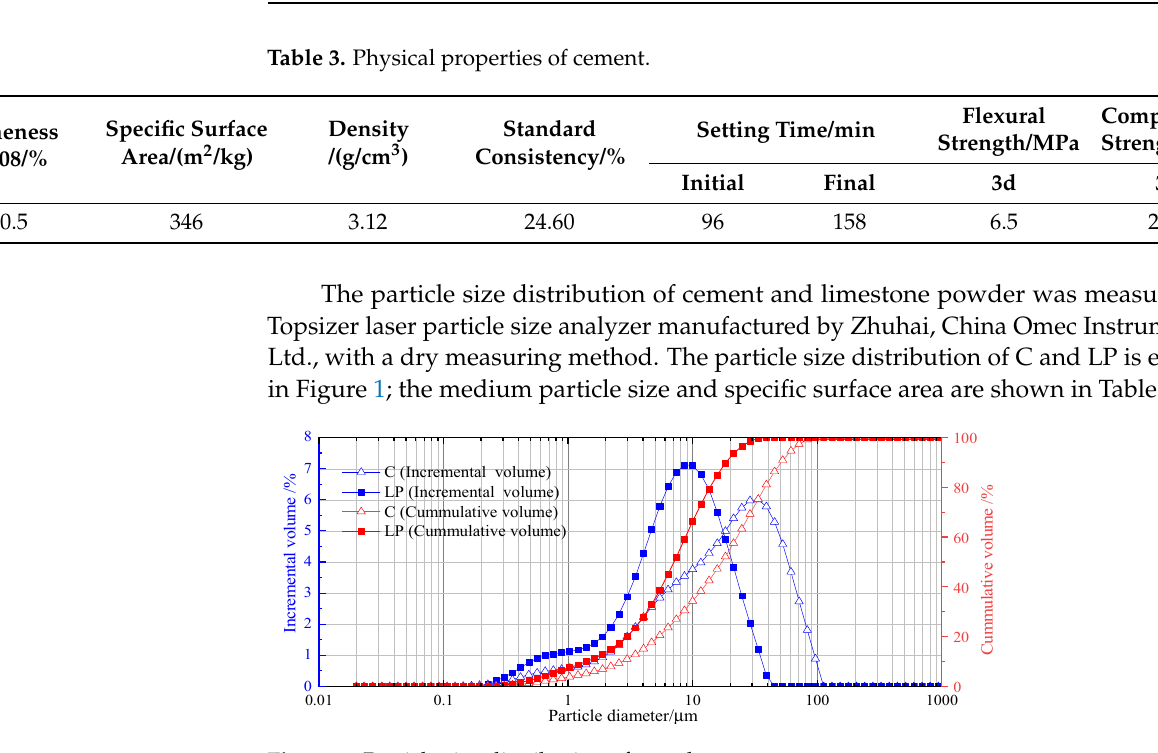
Figure 1. Particle size distribution of powders. Table 4. Medium particle size and specific surface area of cement and limestone powder.